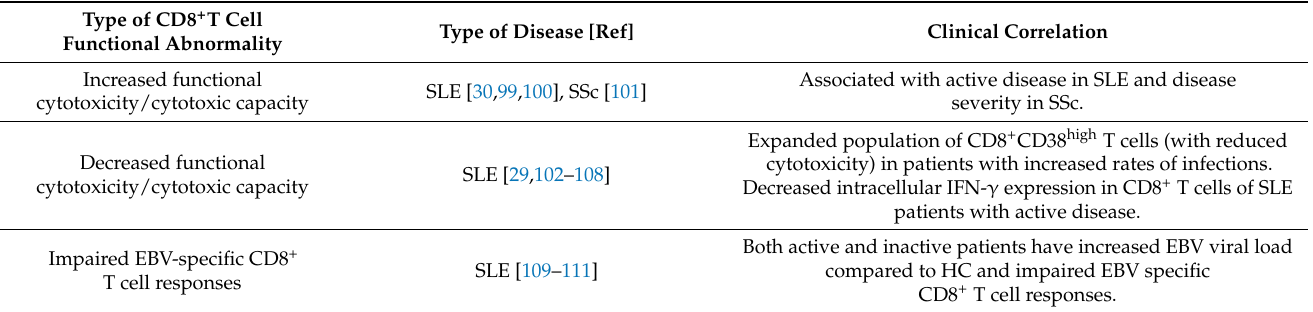
Table 5. CD8 + T cell functional abnormalities in connective tissue diseases.